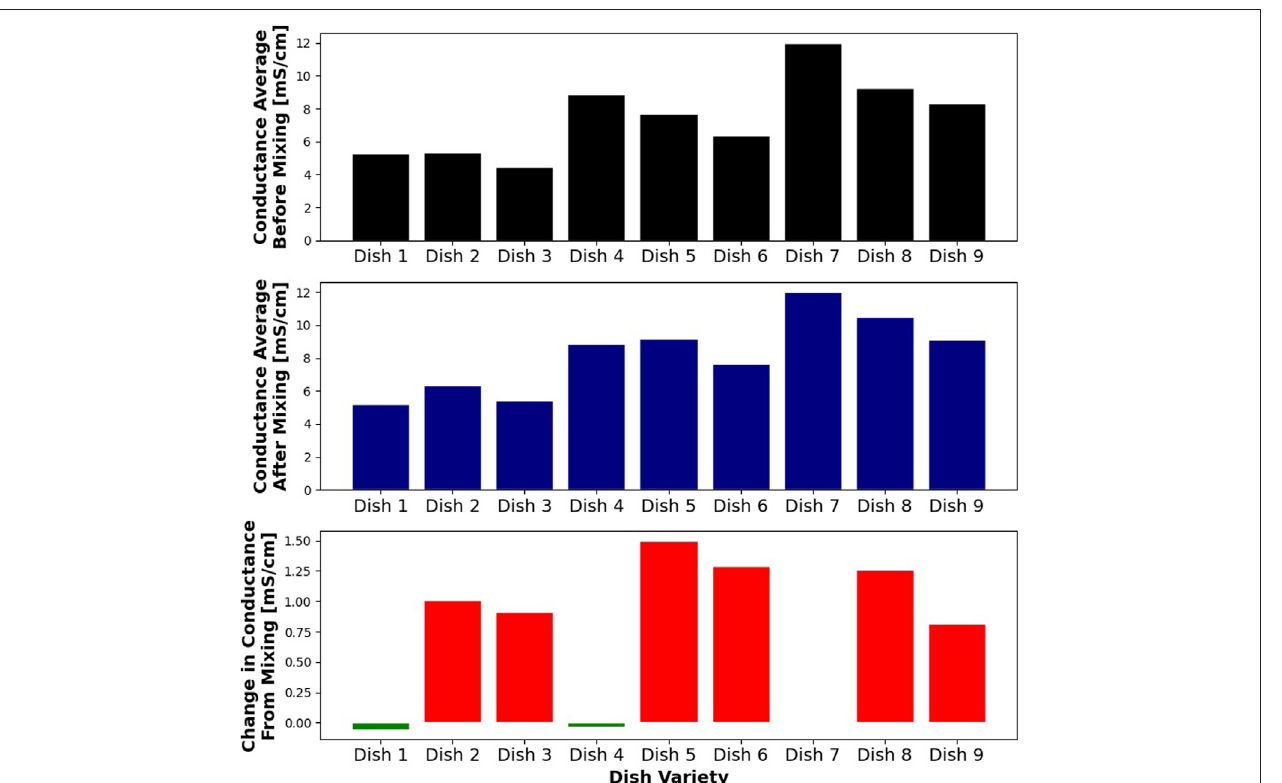
FIGURE 8 | Figure showing the average salinity of gathered samples, before and after mixing, for each dish. Dishes including tomato (red) show an increase in the average salinity due to mechanical processing.